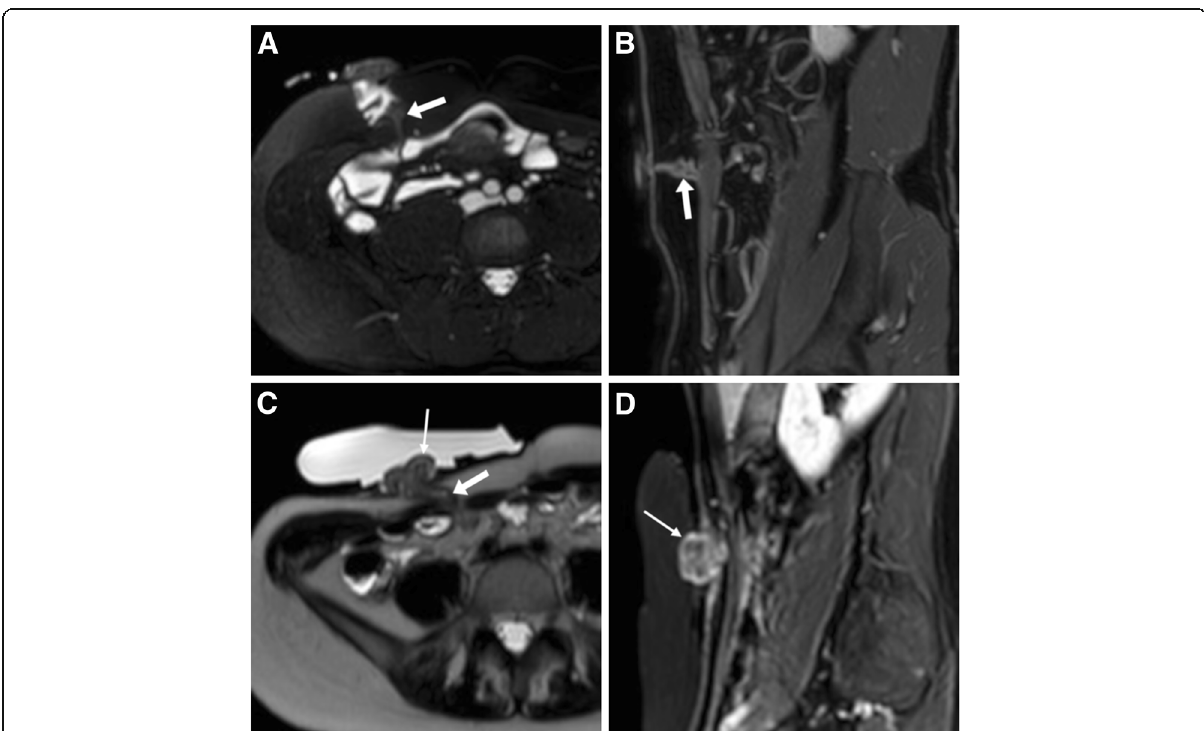
Fig. 8 Normal appearance of ileostomies at MR-enterography in two patients operated for Crohn ’ s disease. a , b Axial fat-suppressed T2-weighted ( a ) and sagittal post-gadolinium fat-suppressed T1-weighted ( b ) images showing collapsed stomal tract (arrow) traversing the abdominal wall, with normal mural thickness and contrast enhancement comparable to that of other small bowel loops. c , d Axial T2- ( c ) and post-gadolinium fat-suppressed T1-weighted ( d ) images showing collapsed stomal tract (arrow), mild protrusion at external orifice (thin arrows), and abundant fluid flowing within stoma bag consistent with stomal